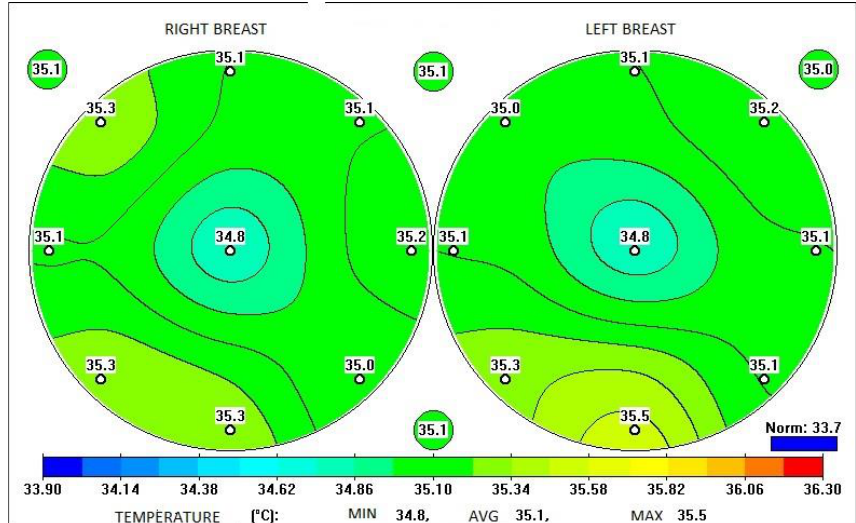
Figure 3. Interface of MWR2020 software. Temperature measurements of a patient with a high probability of breast cancer.